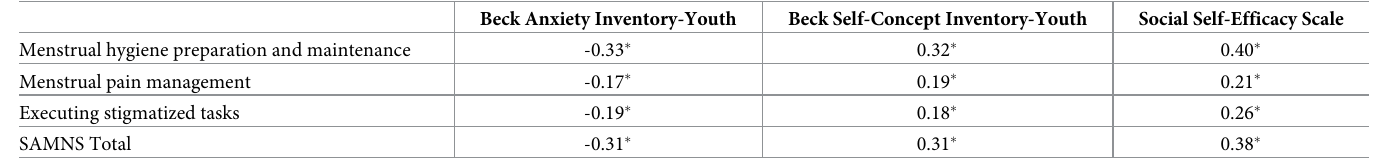
Table 7. Correlations between Self-Efficacy in Addressing Menstrual Needs Scale (SAMNS) scores and validation measures (n =